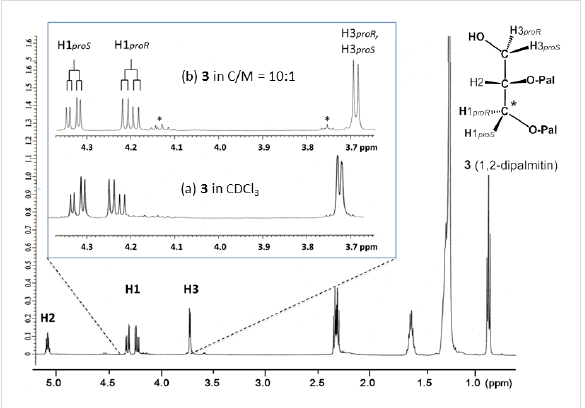
Figure 2: 1 H NMR spectra of 1,2-dipalmitin ( 3 ) in CDCl 3 after partial isomerization into the 1,3-isomer. (a) The expanded spectrum of 3 in CDCl 3, (b) 3 in a mixed solvent with ca. 10% methanol- d 4 in CDCl 3 (C/M ca 10:1, v/v). The signal marked with an asterisk * corressponds to a 1,3-diacyl isomer, which is derived from 3 during storage in a CDCl 3